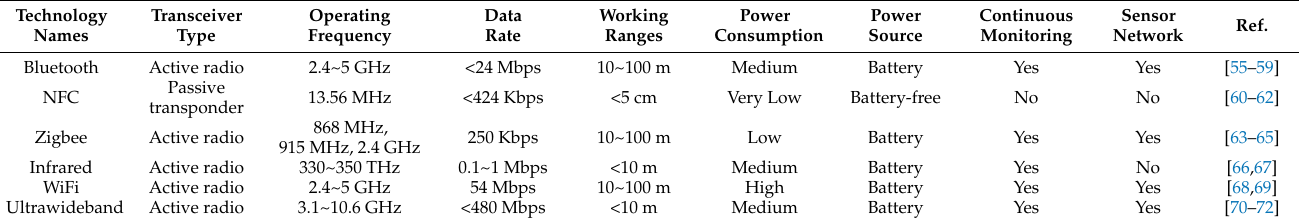
Table 2. Comparison of wireless data communication technologies integrated in smartphones.